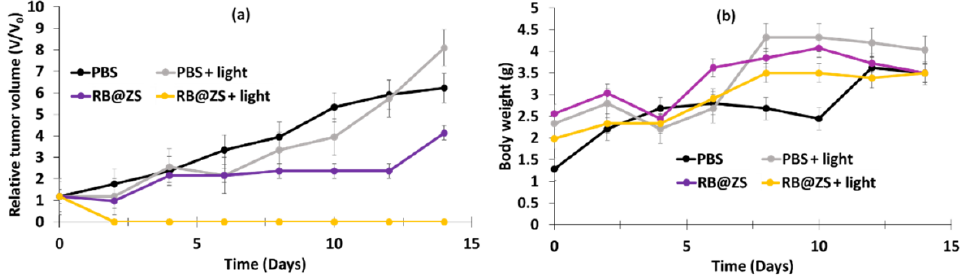
Figure 27. ( a ) Relative tumor volume and ( b ) body weight of the tumor-bearing mice in different treatment groups ( n = 6) during post-treatment with PBS or RB@ZS aqueous solution (30 mg/mL). Laser irradiation at 532 nm (500 mW/cm 2 ) for 10 min. Adapted from Hu et al. [61] .